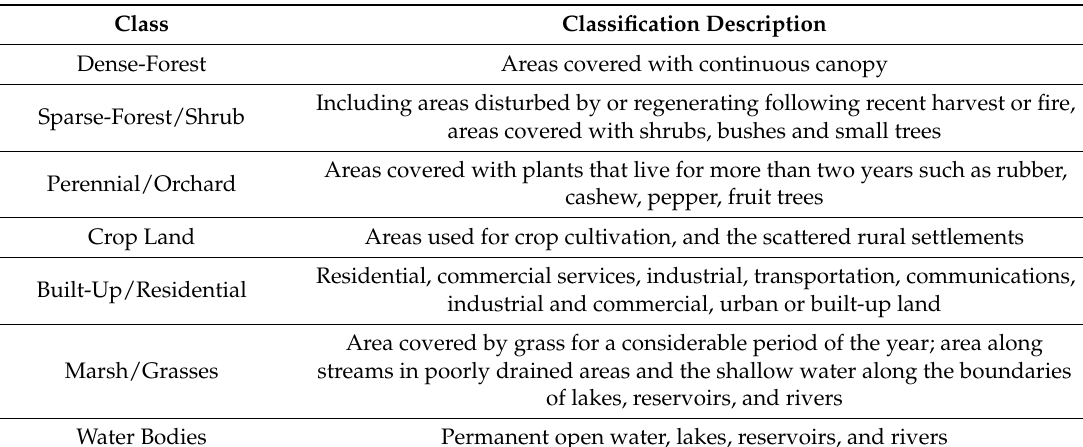
Table 2. Land cover classes